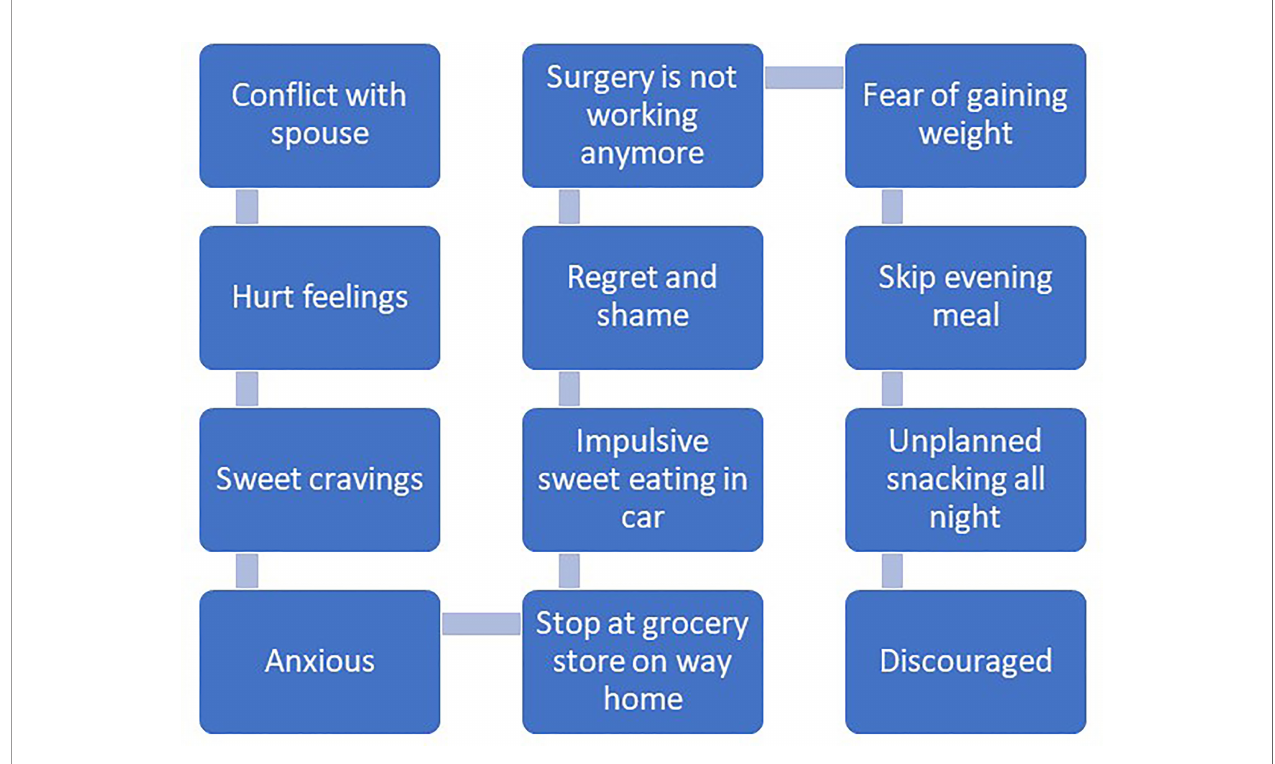
FIGURE 1 | Negative behavioral chain